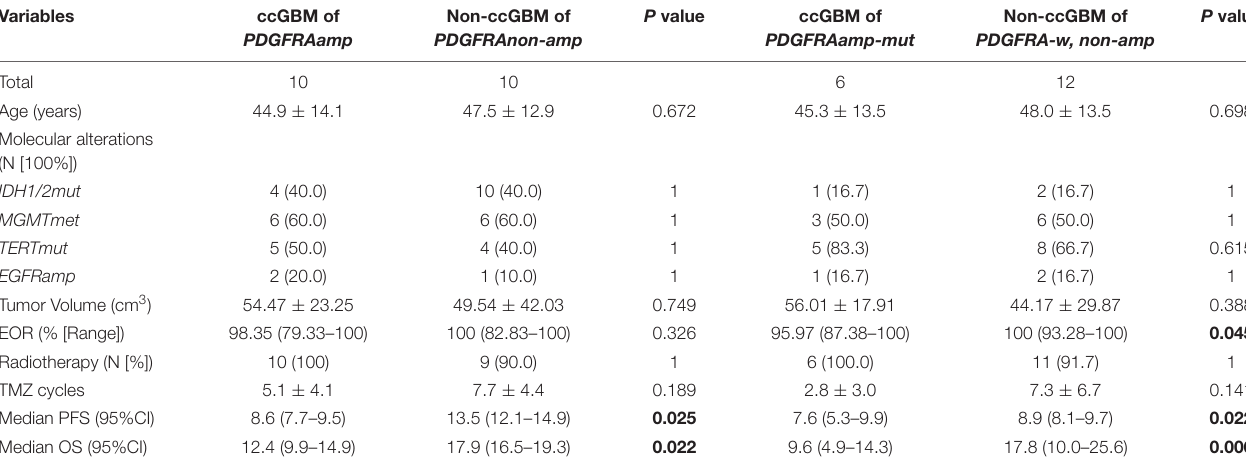
TABLE 3 | Baseline characteristics and survival of matched ccGBM and non-ccGBM.